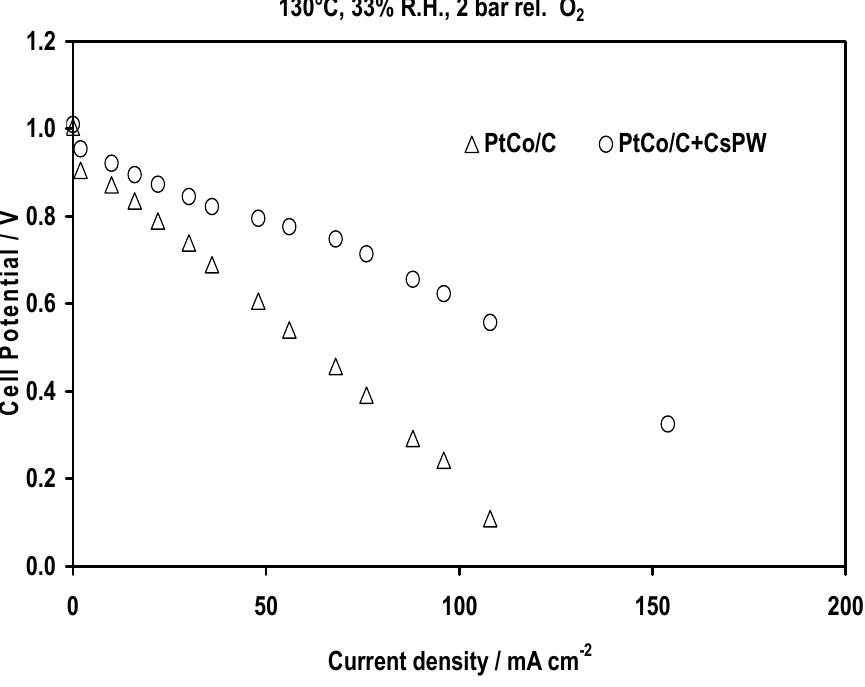
Figure 8. Polarization curves for the promoter-based and the bare MEAs under harsh operating conditions of 130 °C, low relative humidity (33% R.H.), oxygen feed, 2 bar rel. Even if no significant changes in terms of mass activity at conventional temperatures were recorded in the polarization curves of both cathodes with and without CsPW salt, the cyclic voltammetry carried out at 80 °C and full humidification (Figure 9) clearly shows a change in the adsorption profile of OH- and H-species in the presence of the